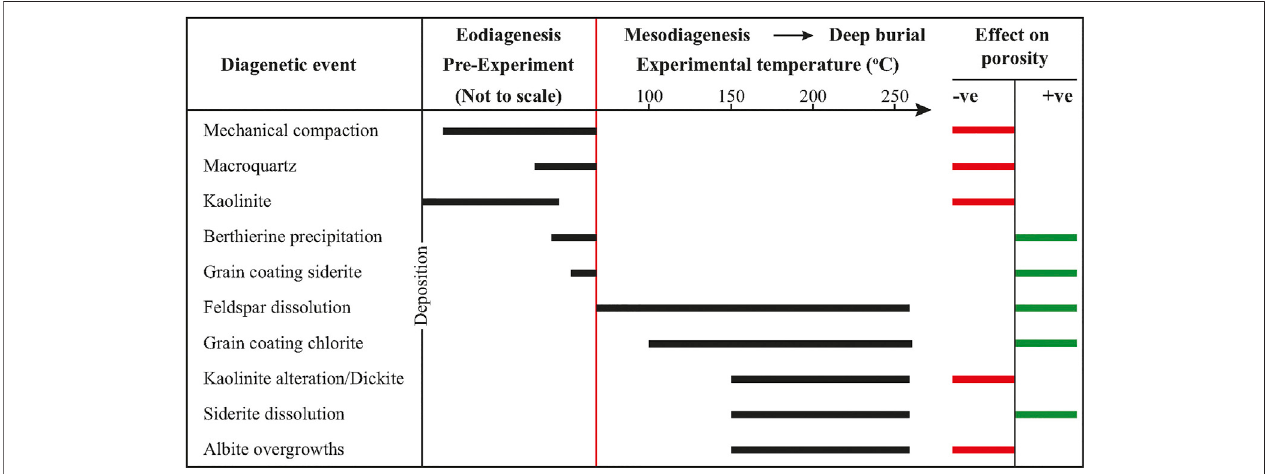
FIGURE 8 | Paragenetic sequence of the main diagenetic processes occurring before and during the hydrothermal experiments with an indication regarding the effectonporosityofeach.Theexperimental temperature rangeofeachprocessisbasedonthe2Dand3DanalysisperformedbyCharlaftisetal.(2021)andthepresent study. Red line separates the pre-to post-reaction diagenetic events and marks the early stage of